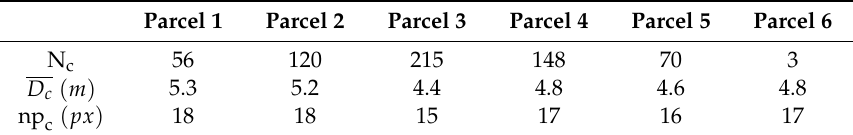
Table 2. Specifications of the templates created based on the crowdsourced